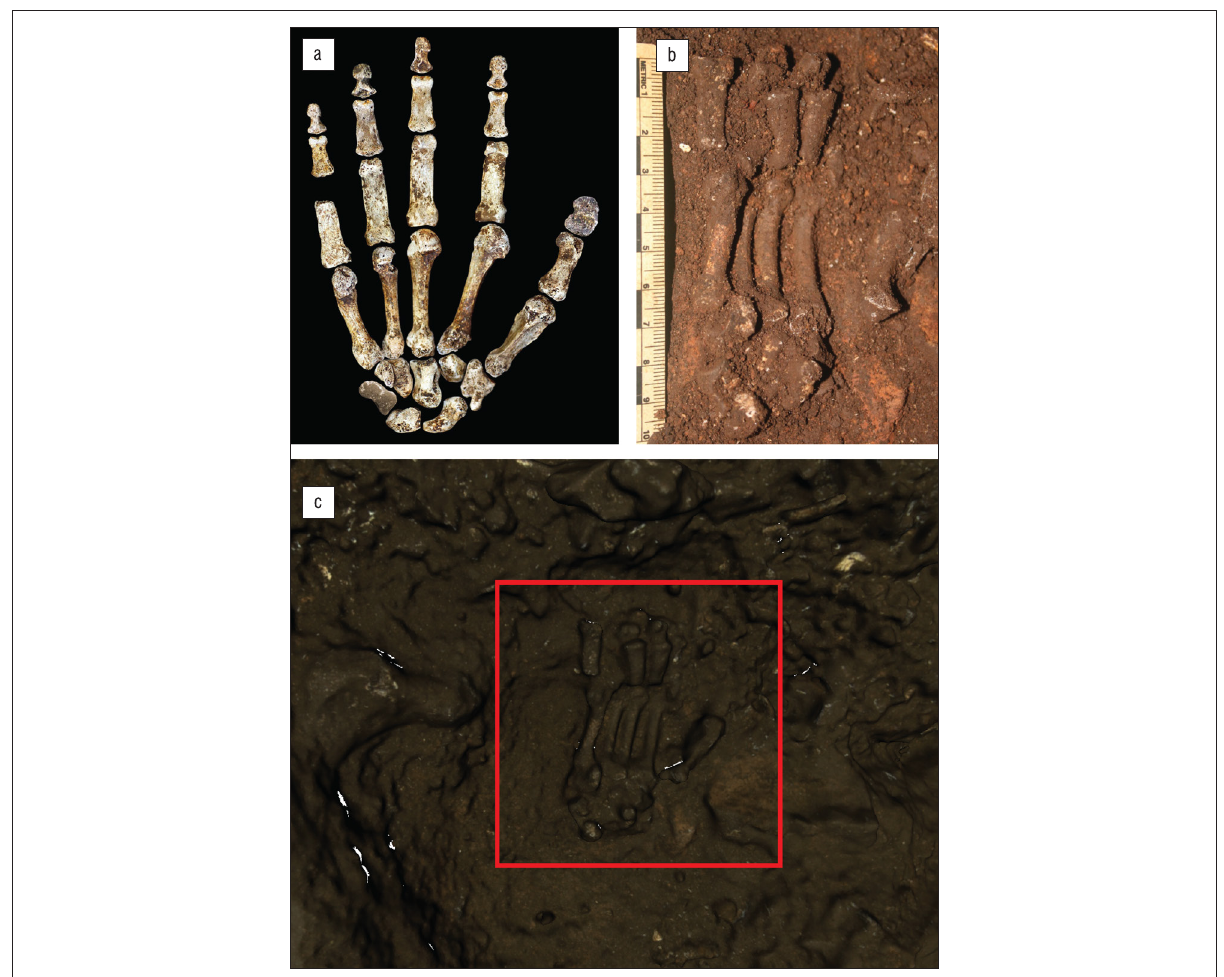
Figure 6: (a) Photograph of the adult ‘Hand 1’ of Homo naledi as described by Kivell et al. 39 ; (b) adult ‘Hand 1’ of H. naledi in situ, prior to excavation; and (c) in-situ white-light source photogrammetry mesh of the area surrounding adult ‘Hand 1’ of H. naledi accomplished with the Artec Eva after alignment, registration and fusion of four separate scans at an average accuracy of 0.35